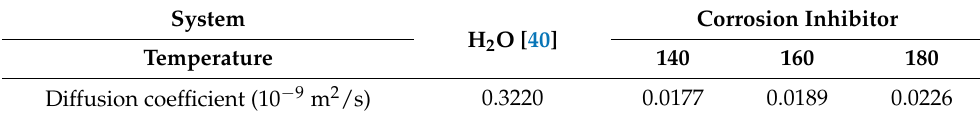
Table 4. Diffusion coefficients of Cl − in corrosion inhibitor films at different temperatures.